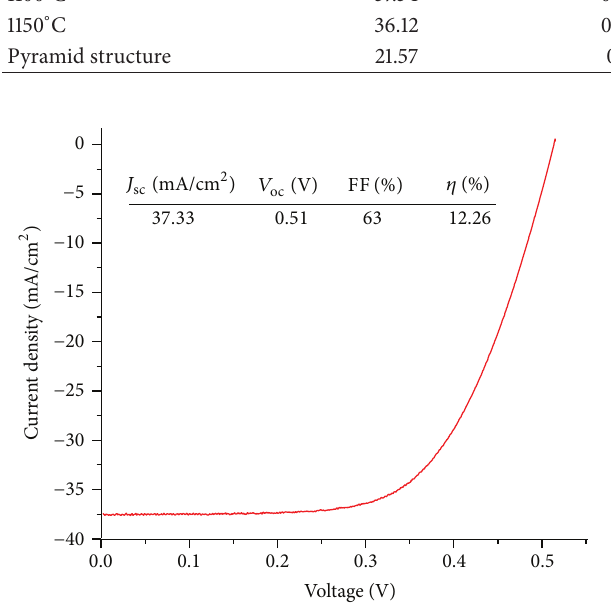
Figure 7: Photoelectric conversion efficiency measurement of the fabricated solar cells with a passivation layer.